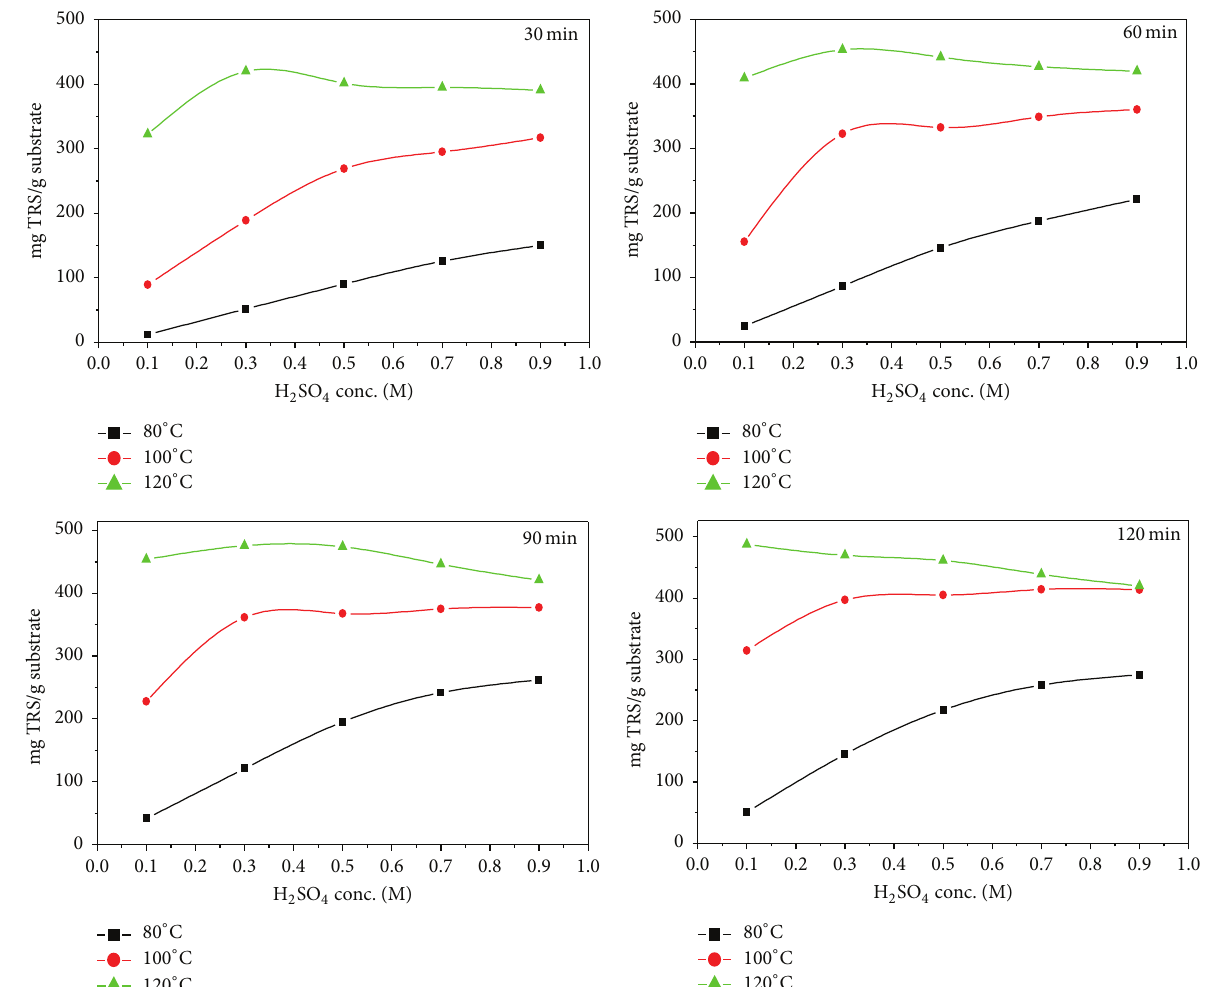
Figure 4: Effect of temperature and H 2 SO 4 concentration at different reaction time on the production of TRS from spent citronella biomass.